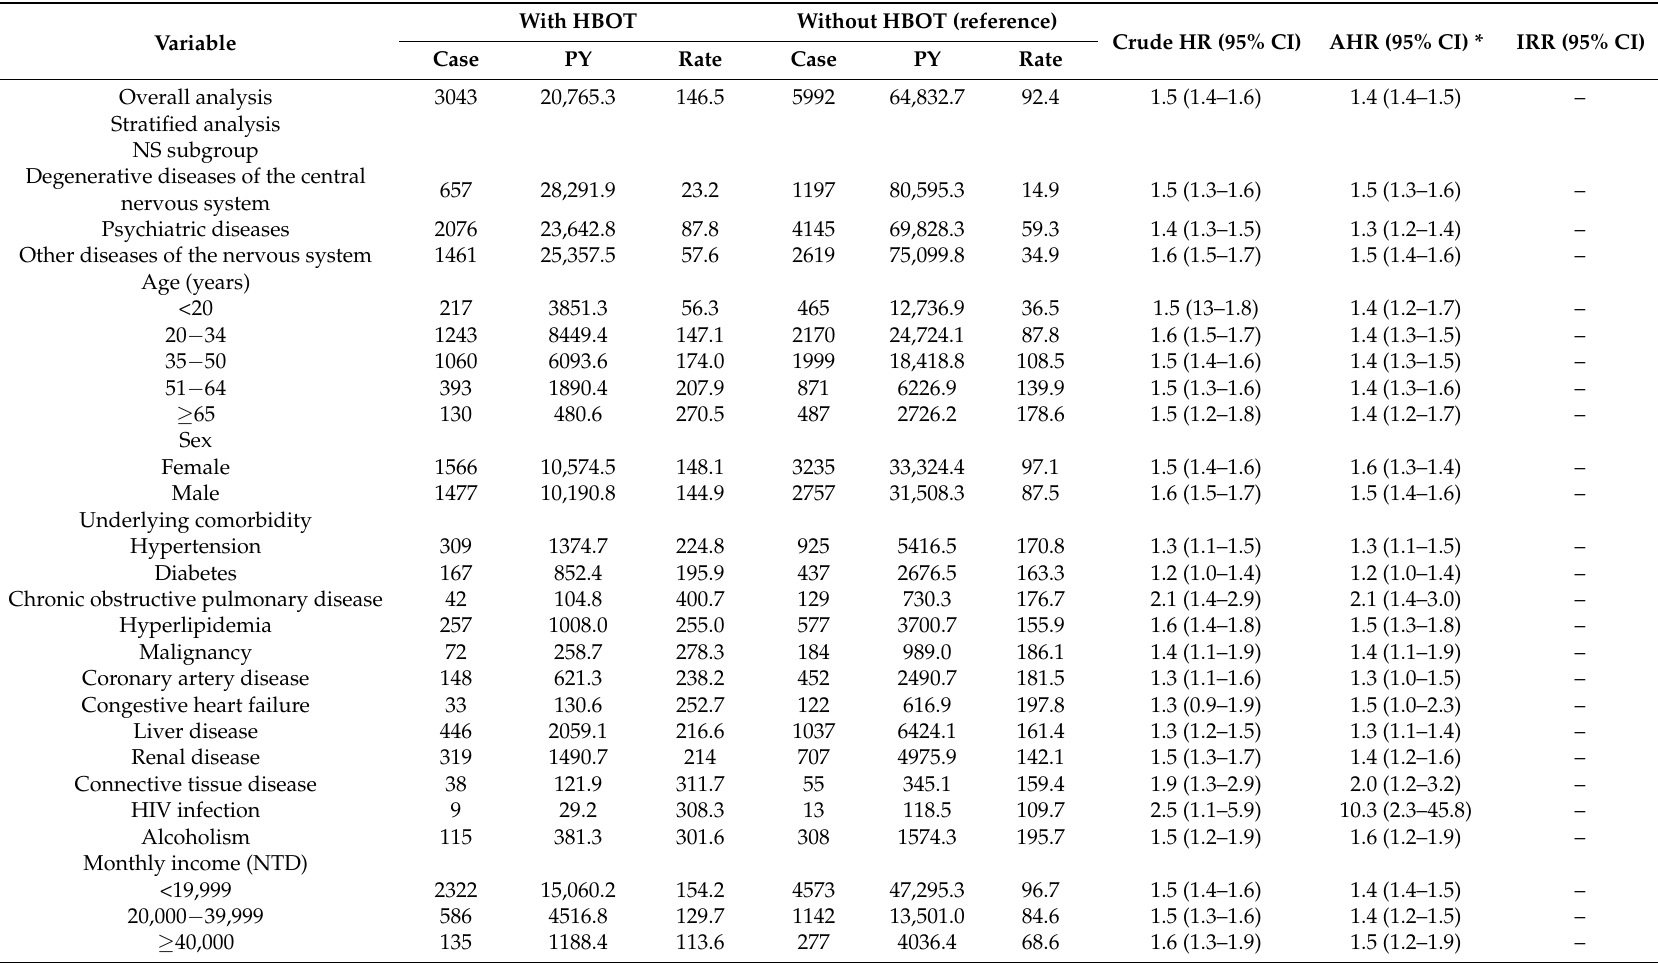
Table 2. Comparison of the risk for NS between patients with COP who received HBOT and who did not by Cox proportional hazard regression and Poisson regression